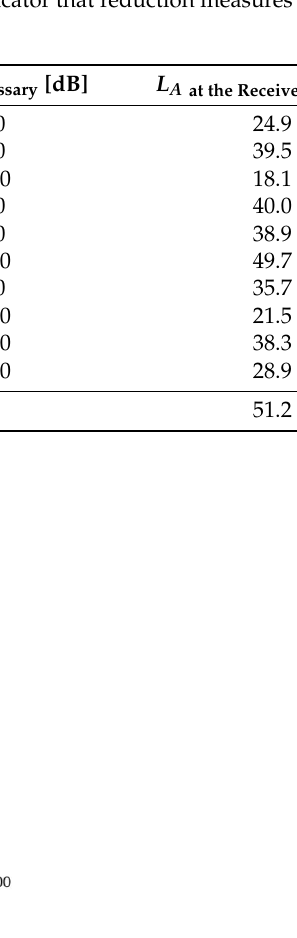
16 of 22 Table 1. Example illustrating how the synthesized third octave band spectrum derived from Fig- ure 11 must be modified to achieve an overall SPL lower than 55 dB(A). The numerical value 20 dB is not a requirement on minimum reduction. It is merely an indicator that reduction measures are needed in that band.